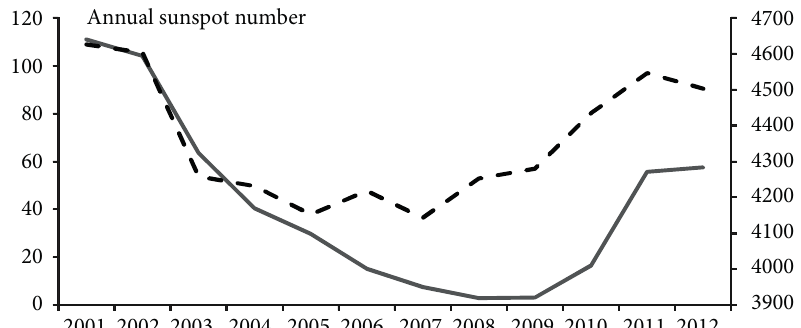
Fig. 1. Annual average values in 2001–2012: sunspots (___), hard cosmic ray flux in Vilnius